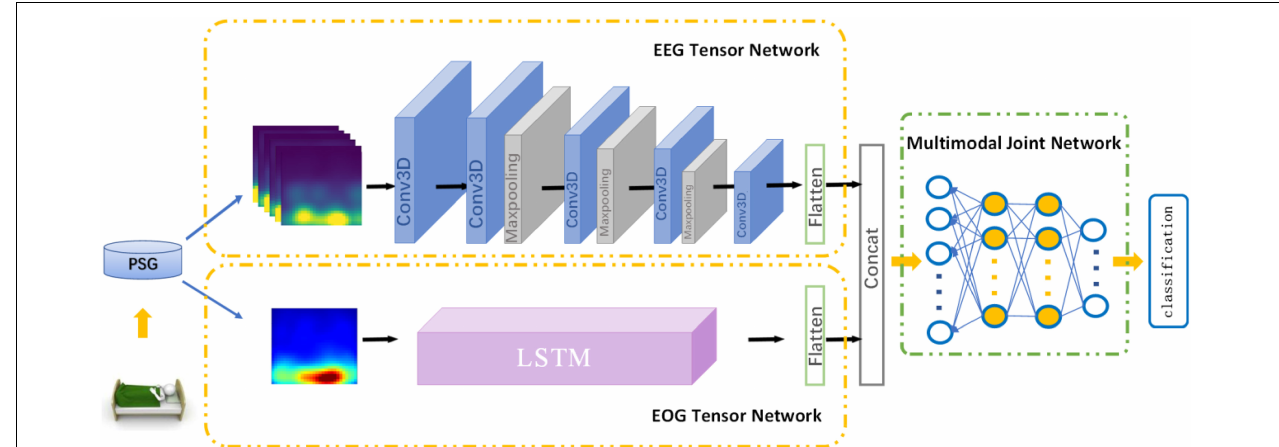
FIGURE 1 | Architecture of